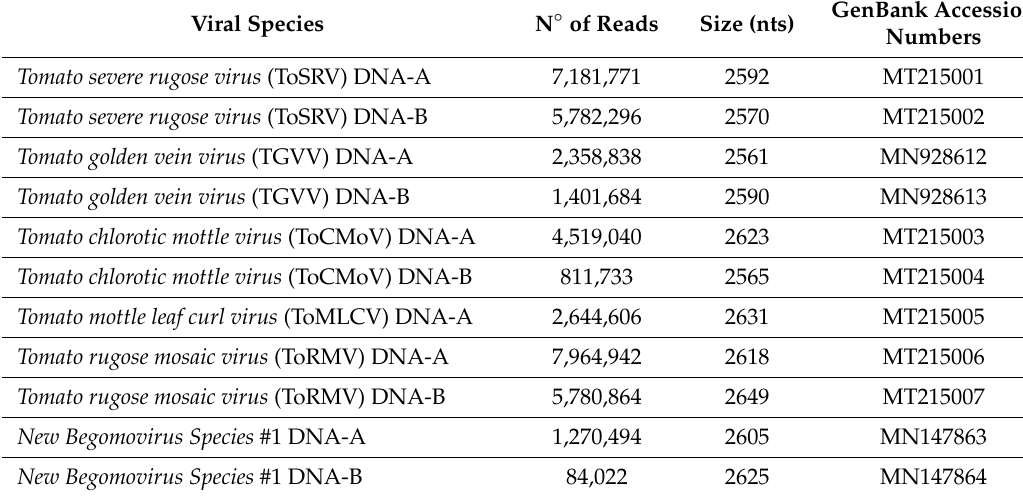
Table 5. Viral circular, single-stranded DNA species (and their corresponding GenBank accessions) detected after Illumina Hiseq sequencing in the pool of tomato DNA samples harboring the Ty -1 gene. Viral